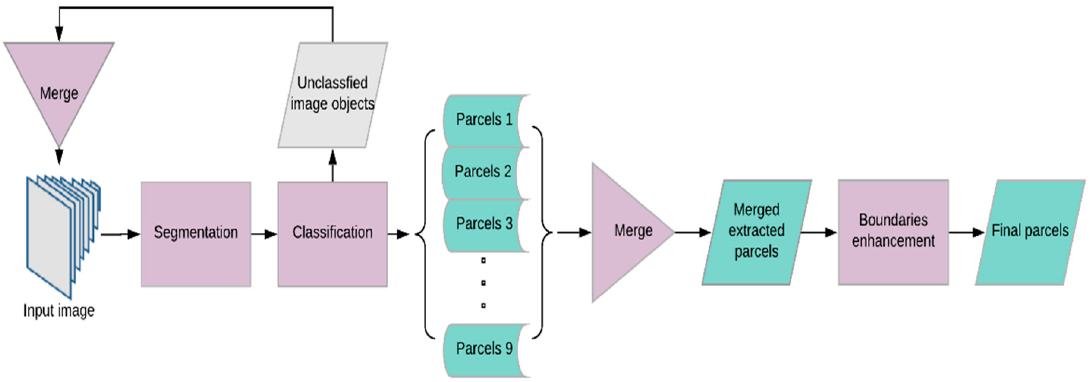
Figure 2. Automated rural parcels’ extraction workflow. Table 1. Parameter tuning with di ff erent steps followed in rule